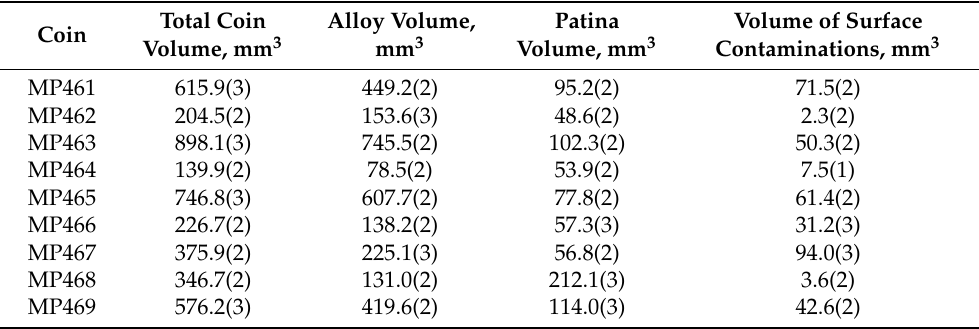
Table 2. The volumes of the coins, copper–tin alloy and patina and surface contaminations obtained from neutron 3D data analysis.